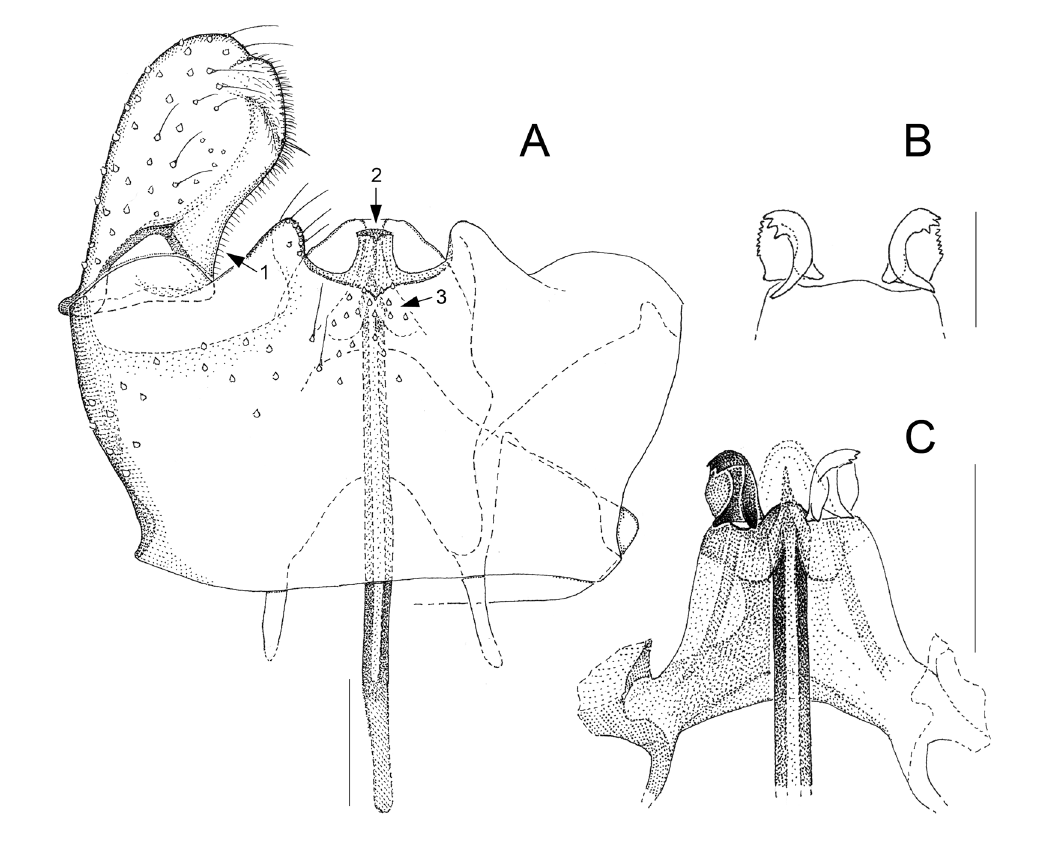
Fig. 5. Glemparon birhojohmi sp. nov., ♂♂. A . Genitalia, ventral, holotype (NZAC, no. CEC1426). B . Tegminal processes, ventral, paratype (NZAC, no. CEC1427). C . Apex of ejaculatory apodeme and tegmen, ventral, holotype. Scale bars: A, C = 0.05 mm; B = 0.025 mm. Numbered arrows indicate diagnostic characters (see